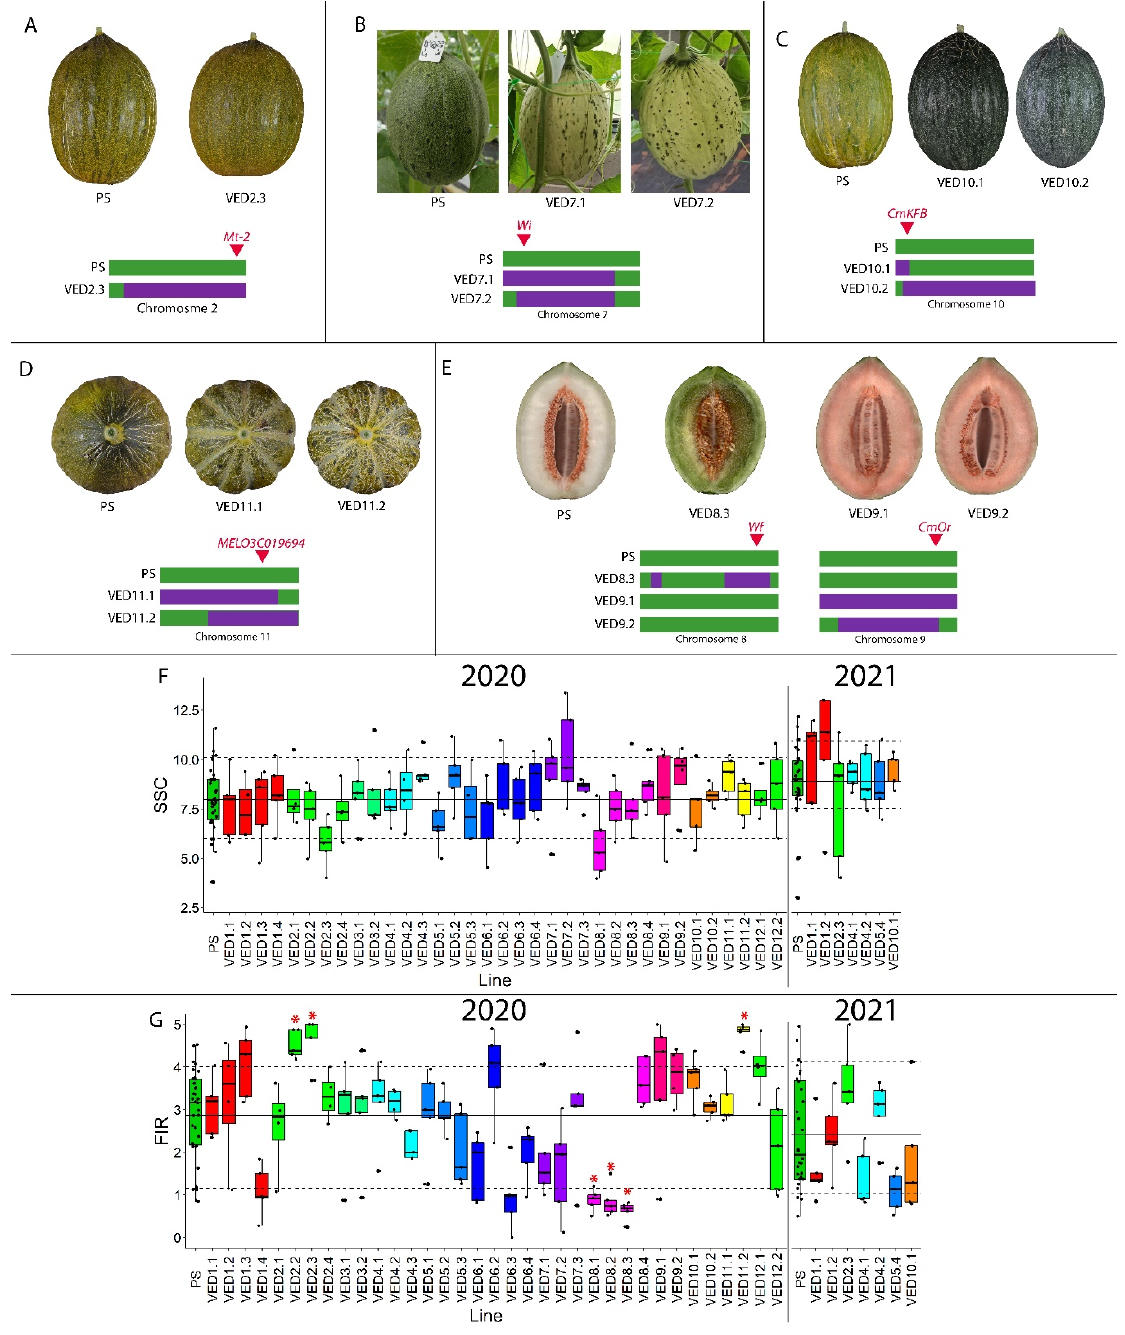
Figure 4. Fruit ‐ quality ‐ related phenotypes of the population in 2020 and 2021. ( A ) Presence of spots in the rind (mottled rind), with a representation of chromosome 2 and the reported causal gene. ( B ) Immature rind color, with a representation of chromosome 7 and the reported causal gene. ( C ) Yellowing of the rind, with a representation of chromosome 10 and the reported causal gene. ( D ) Presence of sutures in the rind, with a representation of chromosome 11 and the reported causal gene. ( E ) Flesh color, with a representation of chromosomes 8 and 9 and the reported causal genes. ( F ) Soluble solid content (SSC) in °Brix. ( G ) Flesh firmness (FIR) in kg cm − 2 . (F,G) Replicates are represented with dark circles; red asterisk indicates p ‐ value < 0.05; different colors indicate different chromosomes.